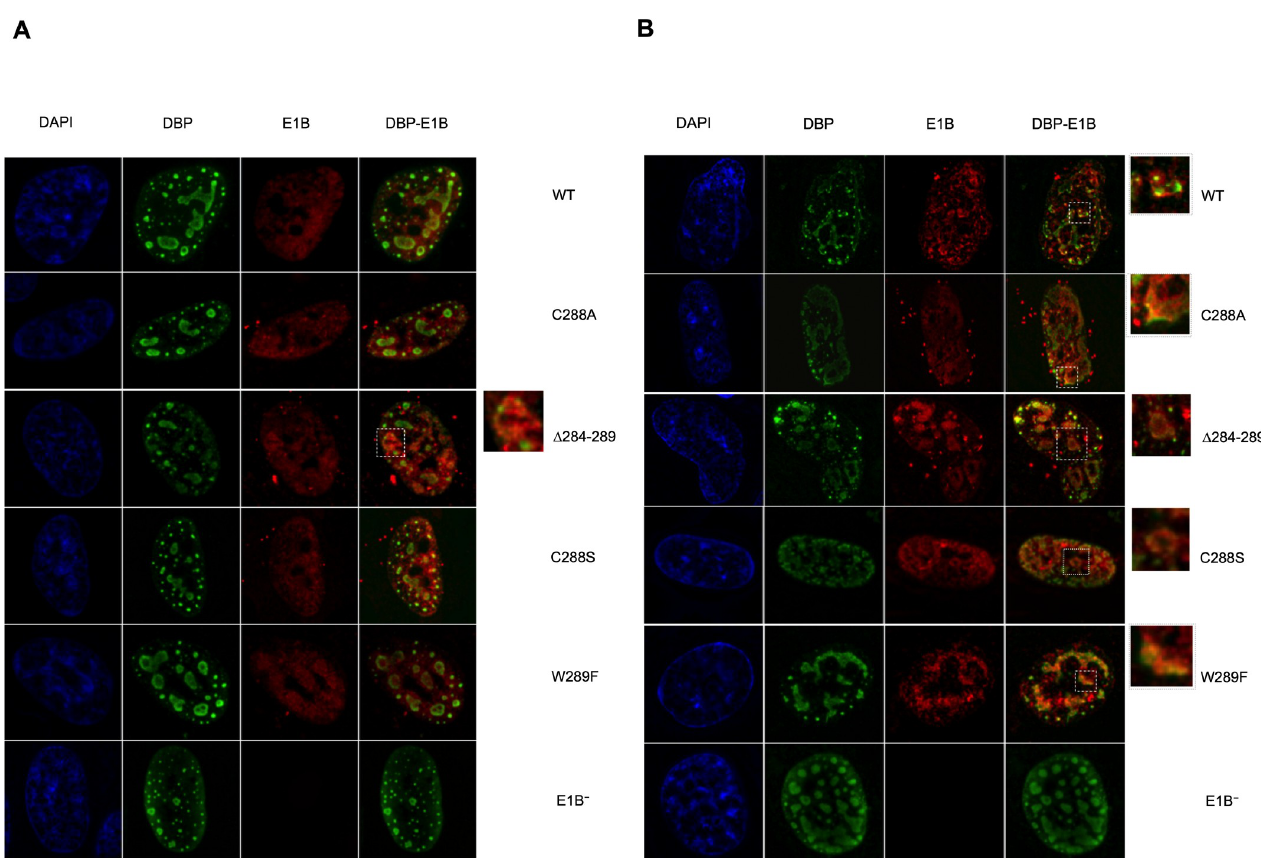
Fig 6. Localization of DBP and E1B 55K to viral RC in Ad5 WT- or RNP mutants-infected HFF cells. HFF cells infected with Ad5 WT or E1B 55K mutant viruses were fixed and processed for immunofluorescence as described in materials and methods. Blue (DAPI), green (DBP), red (E1B 55K). (A) 24hpi, (B) 36hpi. Results shown are representative of at least two independent